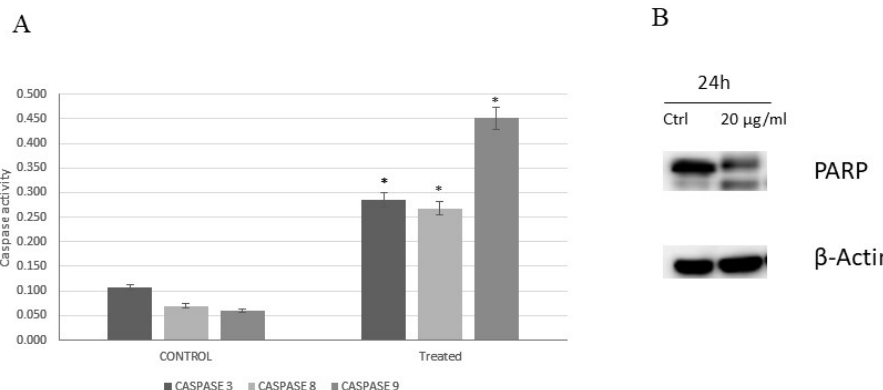
Figure 4. ( A ) Caspases 3, 8, and 9 activity on AGS cells. The control group received no treatment, and the treated group was treated with 20 µ g/mL of carnosic acid for 24 h, * p < 0.001. ( B ) The effect of carnosic acid on the cleavage of PARP analyzed by Western blotting. The cells were treated with vehicle (0.1% DMSO) or treated with carnosic acid at 20 µ g/mL for 24 h.